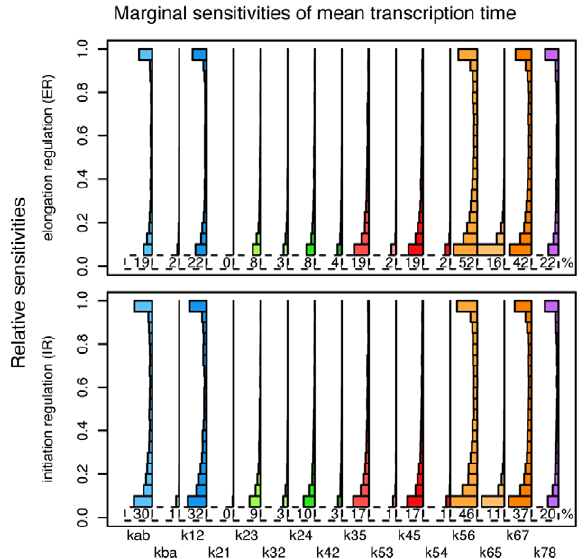
Figure 6. Sensitivity analysis for mean expression time. Histograms of the marginal distributions of relative sensitivities for both the ER and IR schemes, across uniform random samples from parameter space, as described in the text. The smallest bin of the histogram (values below : 05 ) is disproportionately large, and so is omitted; shown instead is the percent of parameter space on which the relative sensitivity is at least : 05 . Note that often only a single parameter dominates (many sensitivities are near 1), that many parameters are almost never influential, and that ER and IR are similar except for the addition of sensitivity to k ab